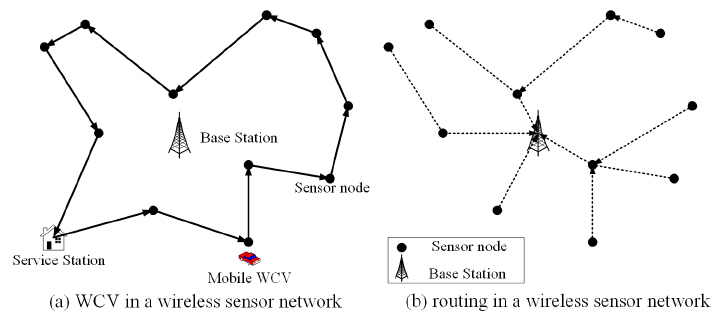
Figure 2. A wireless sensor network with a mobile